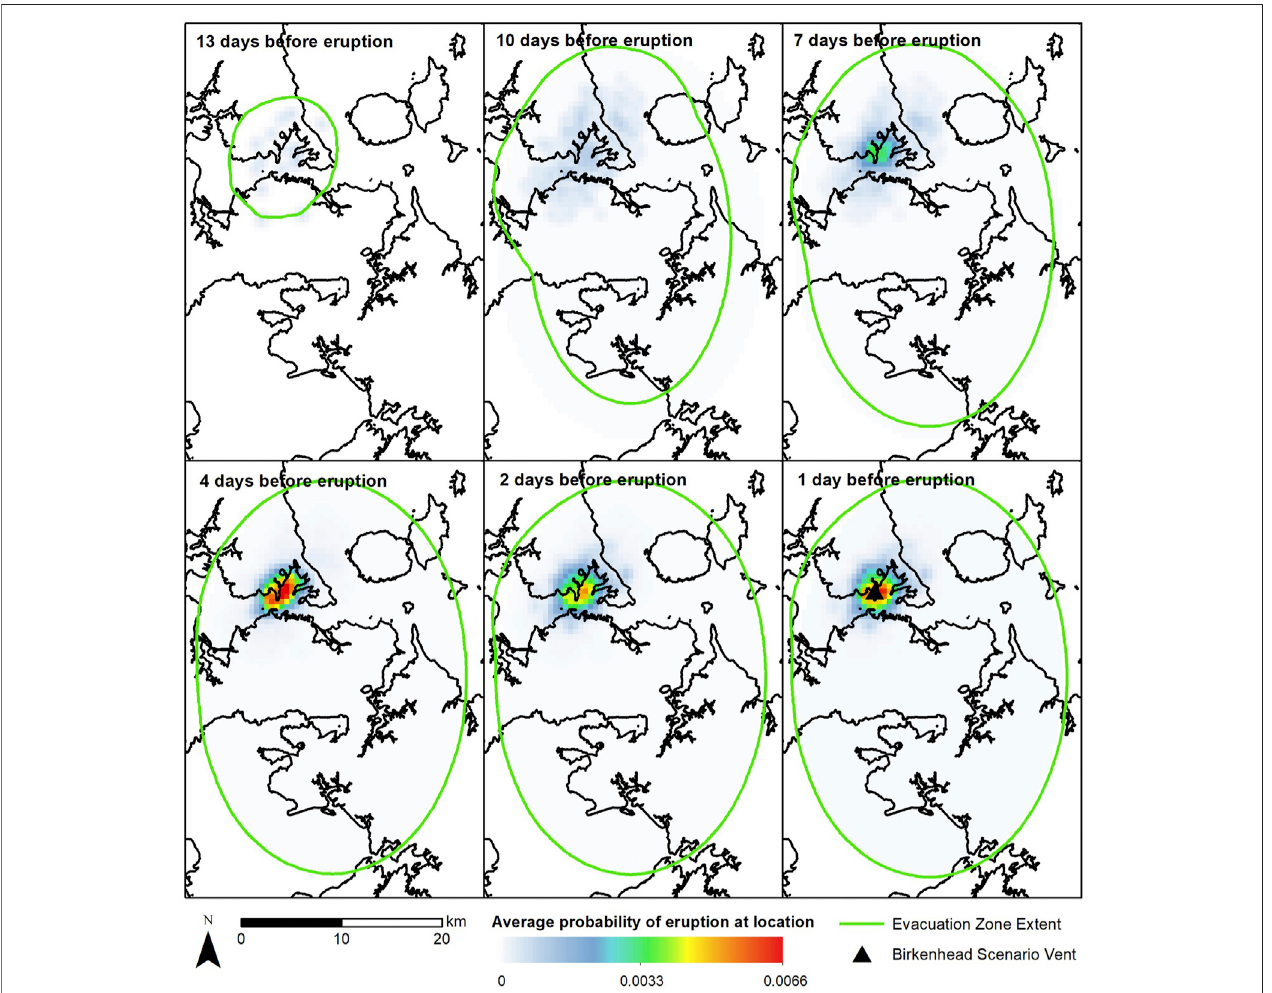
FIGURE 7 | Spatial distribution of absolute eruption probabilities for the Birkenhead scenario from BETEF_AVF with a uniform prior vent model for selected days leading up to the eruption. The green contour encompasses the evacuation zone extent based on cost-bene fi t analysis.